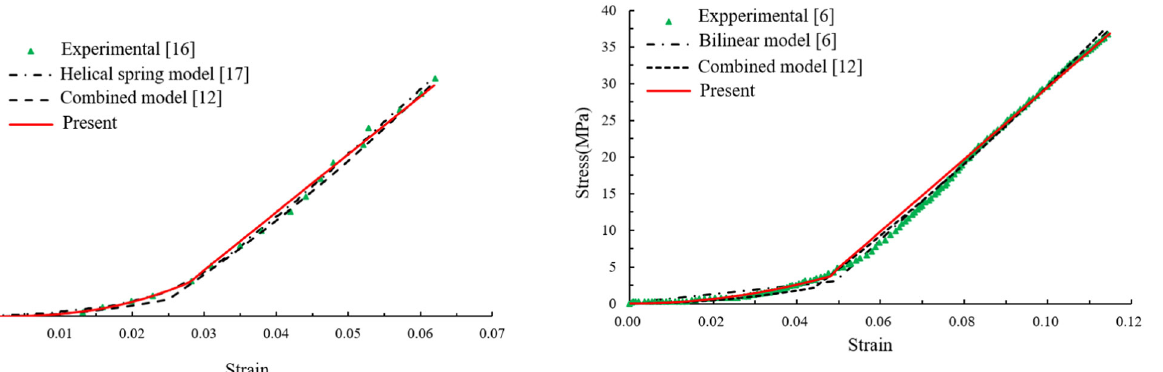
Fig. 3 Constitutive behavior of the rabbit medial collateral ligament Table 2 The identi fi ed parameters for the rabbit medial collateral ligament